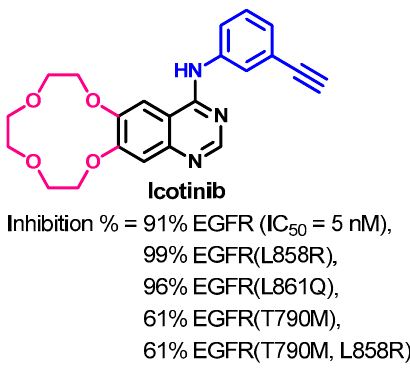
Figure 37. Kinase inhibitory activity of icotinib.